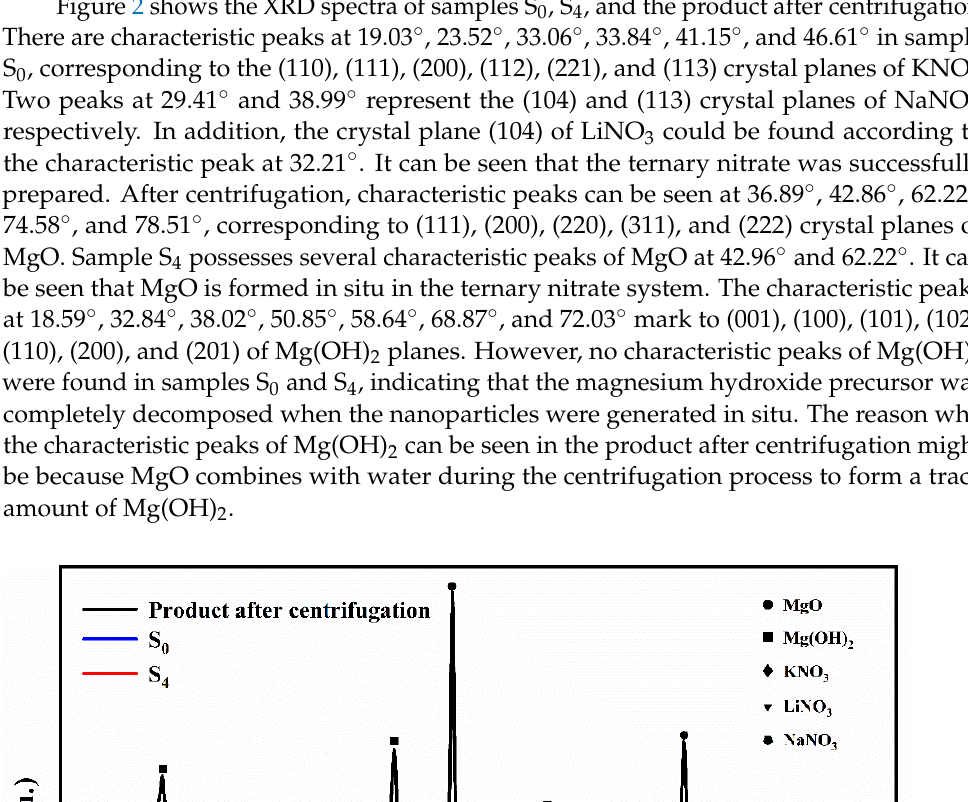
0 , S 4 , and product after